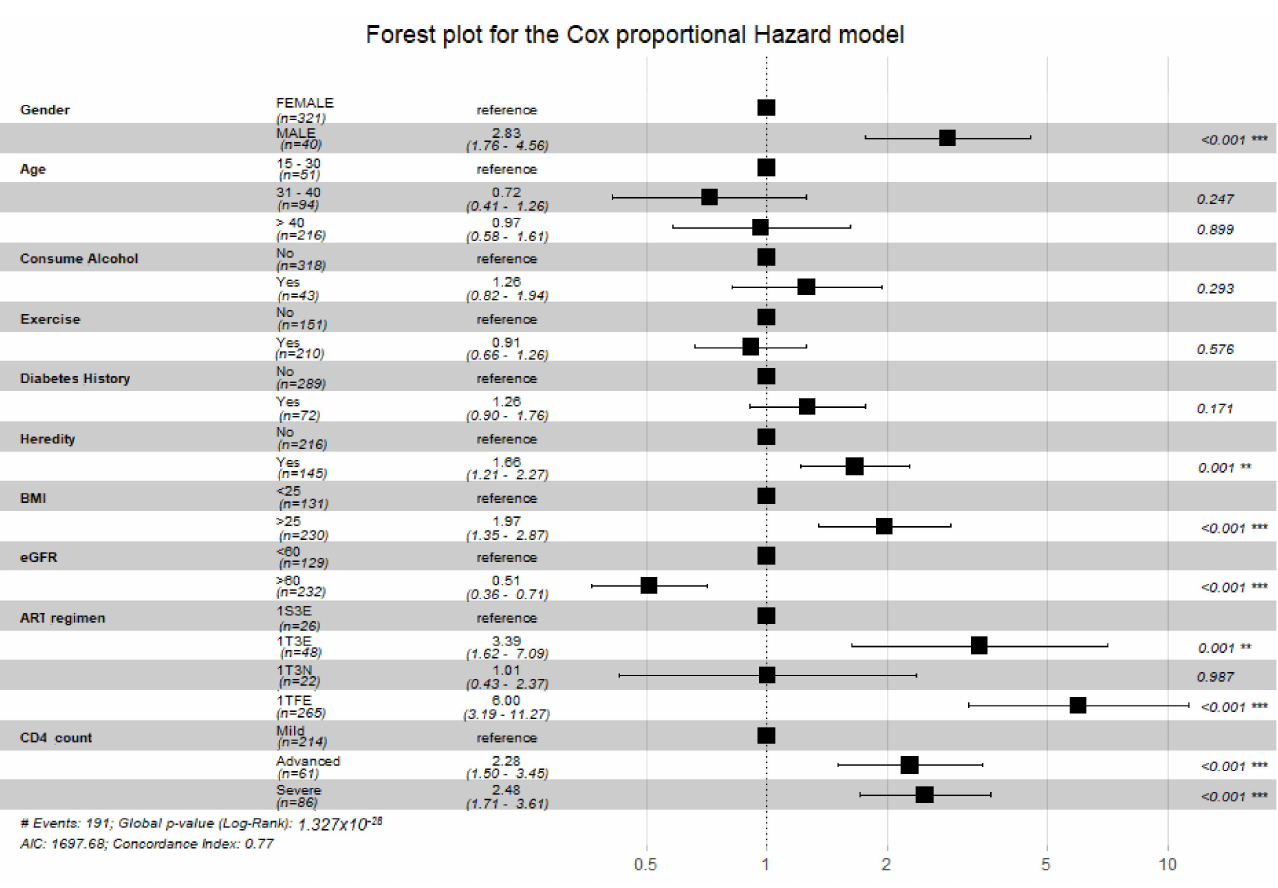
Figure 2. Forest plot for the Cox proportional hazard model. BMI: body mass index; eGFR: estimated glomerular filtration rate; ART: antiretroviral therapy; HR: hazard ratio; CI: confidence interval; WHO: World Health Organization; **: <0.001; ***: